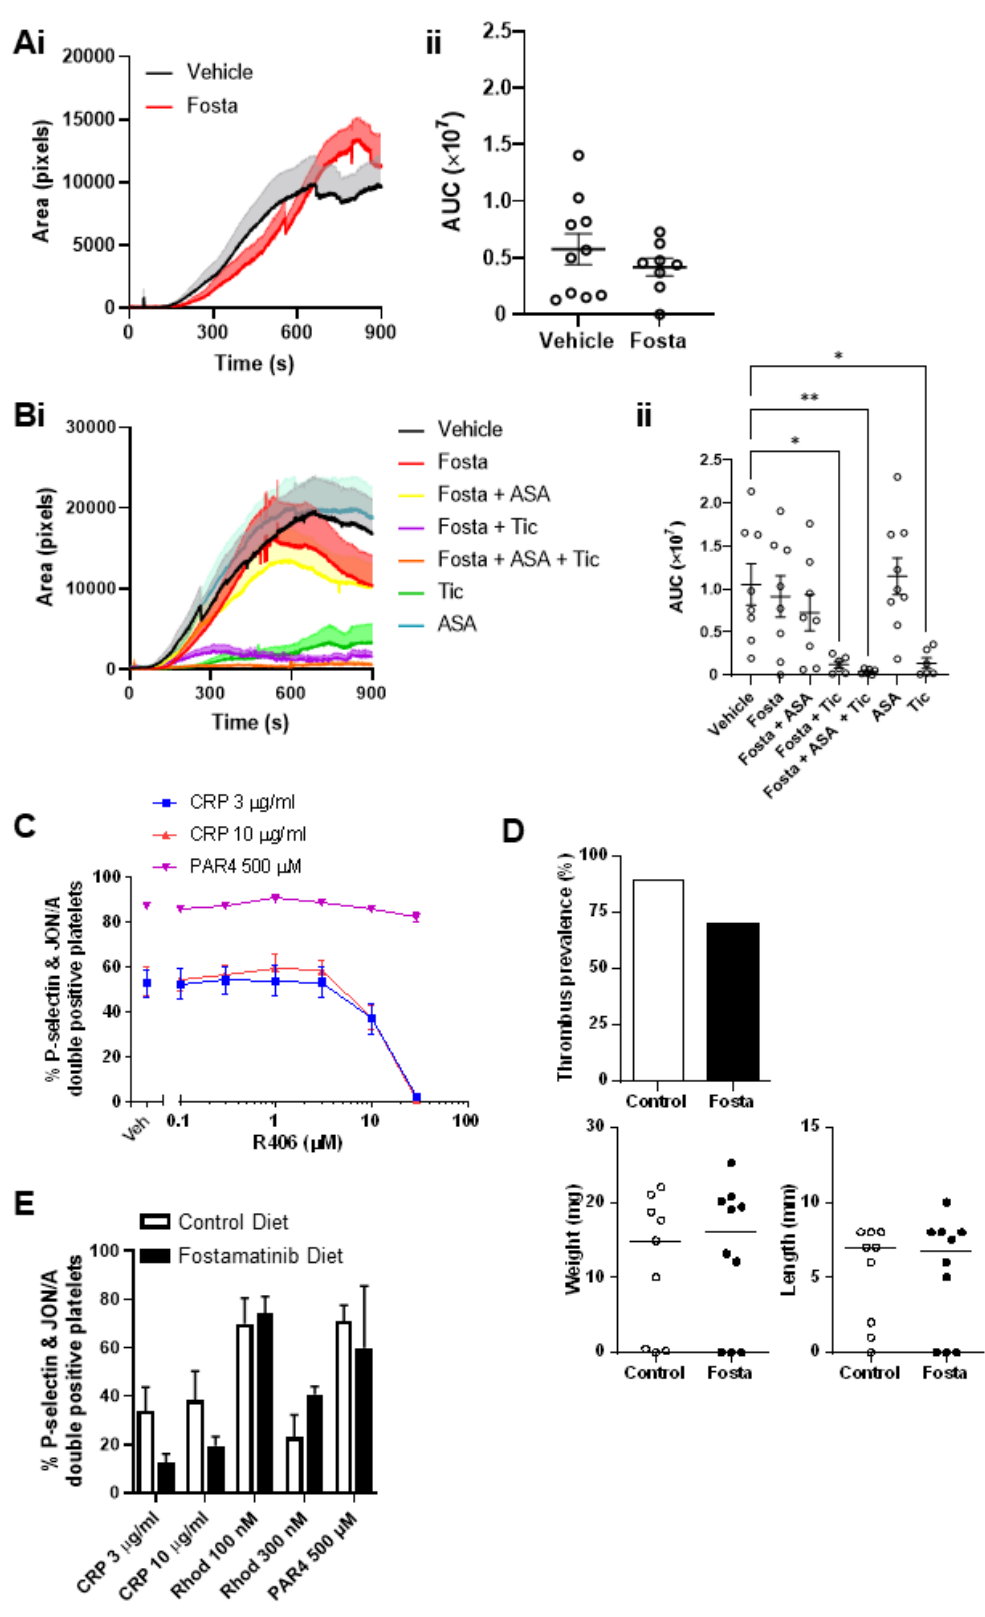
Figure 7. Fostamatinib does not affect arterial or venous thrombus formation in mice. Ferric chloride-induced thrombosis in wild-type mice orally dosed with ( A ) fostamatinib (80 mg/kg) or DMSO vehicle or ( B ) fostamatinib (80 mg/kg) in combination with aspirin (25 mg/kg) and ticagrelor (30 mg/kg).